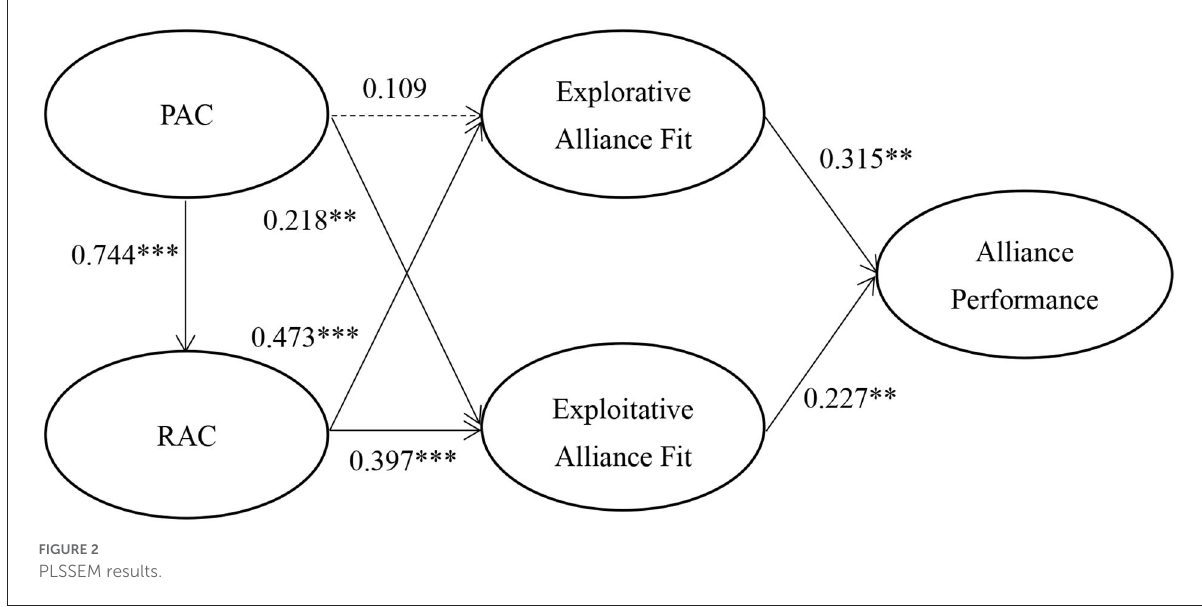
FIGURE2 PLSSEM results.